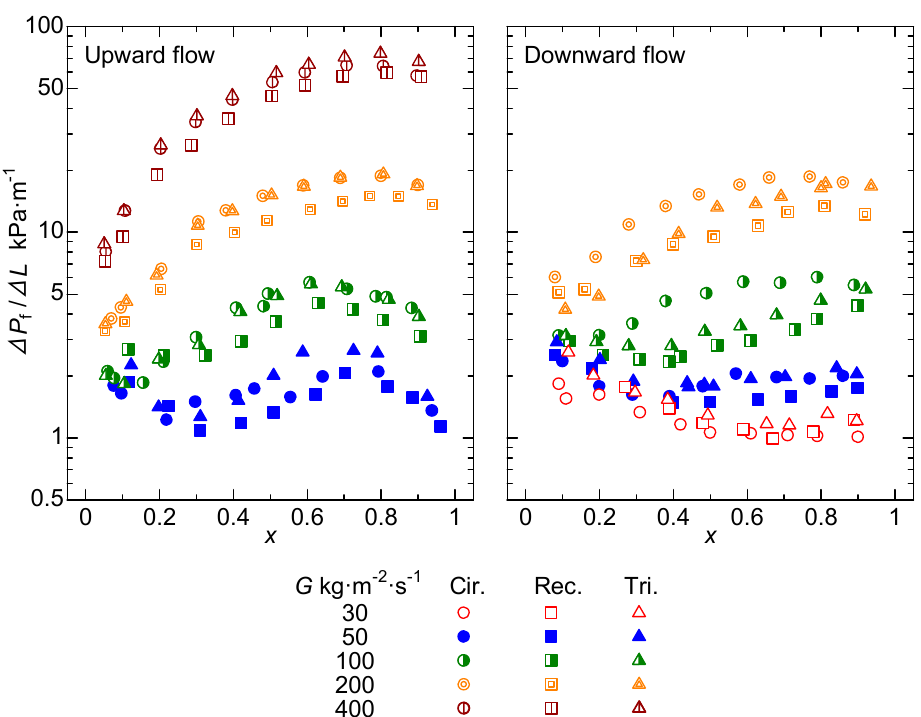
Figure 8. Frictional pressure drop vs. quality flowing upward and downward in circular, rectangular, and triangular tubes.